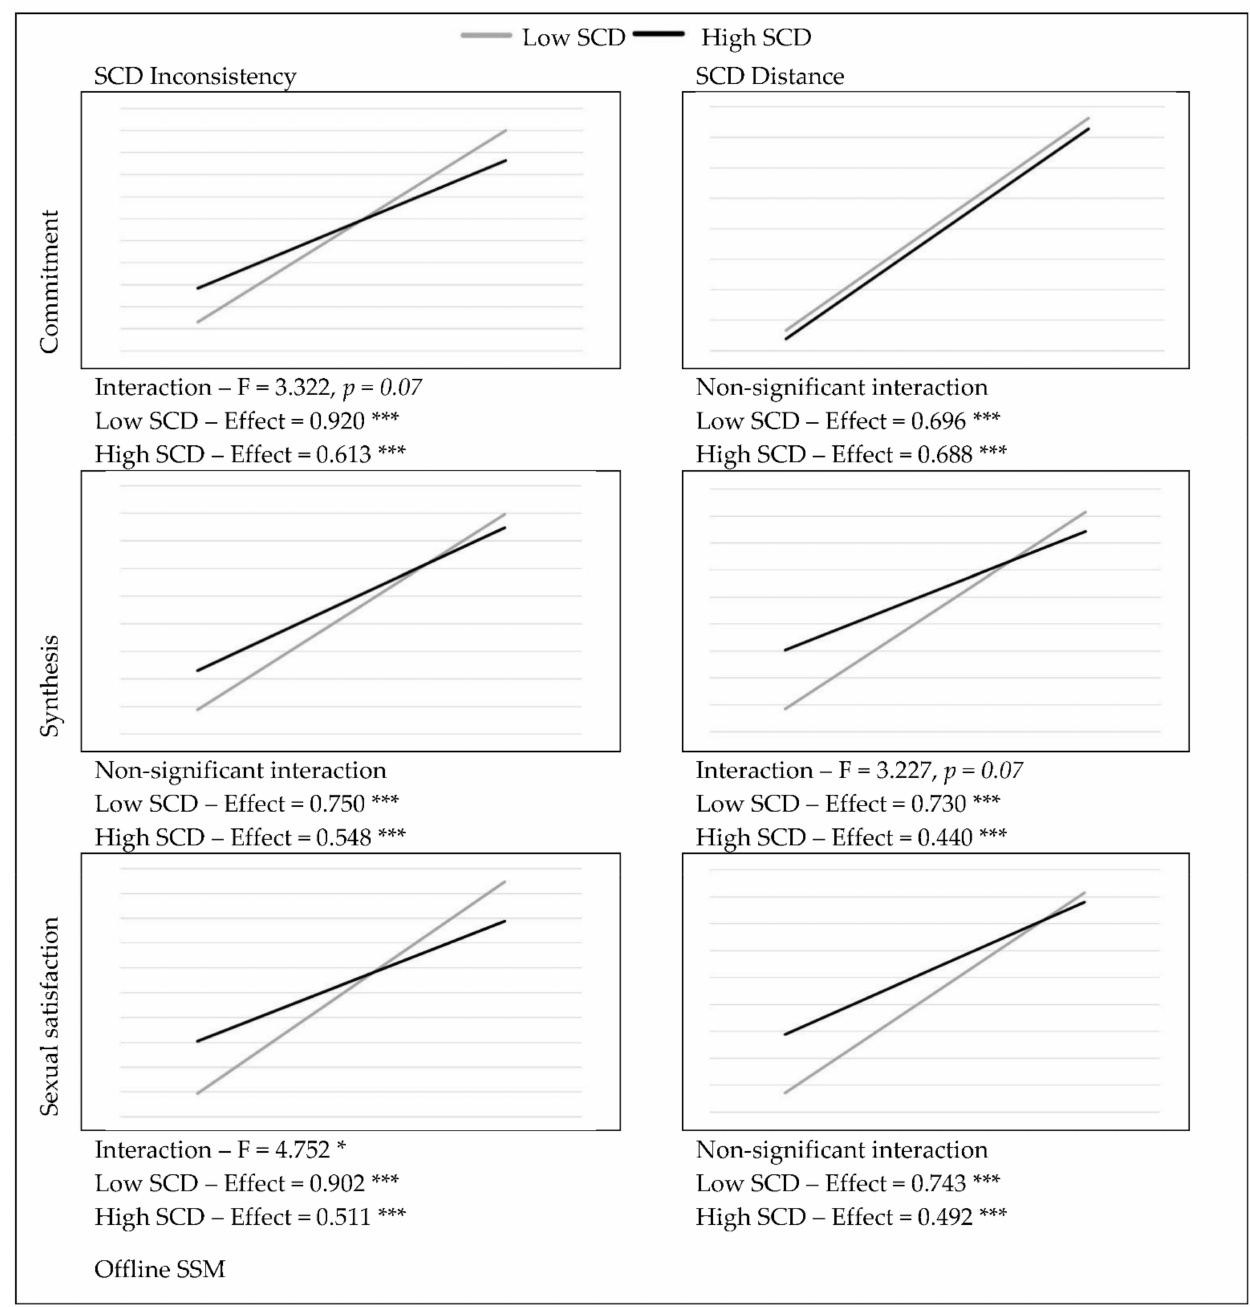
Figure 1. Effects of offline SS on Sexual identity and Sexual satisfaction (standardized means). * p < 0.05, *** p <